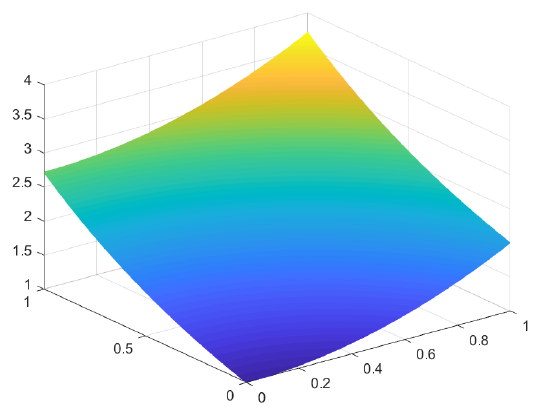
The exact solution u and the numerical solution u h of B.C. V are shown in Figure 11 and Figure 12, respectively.